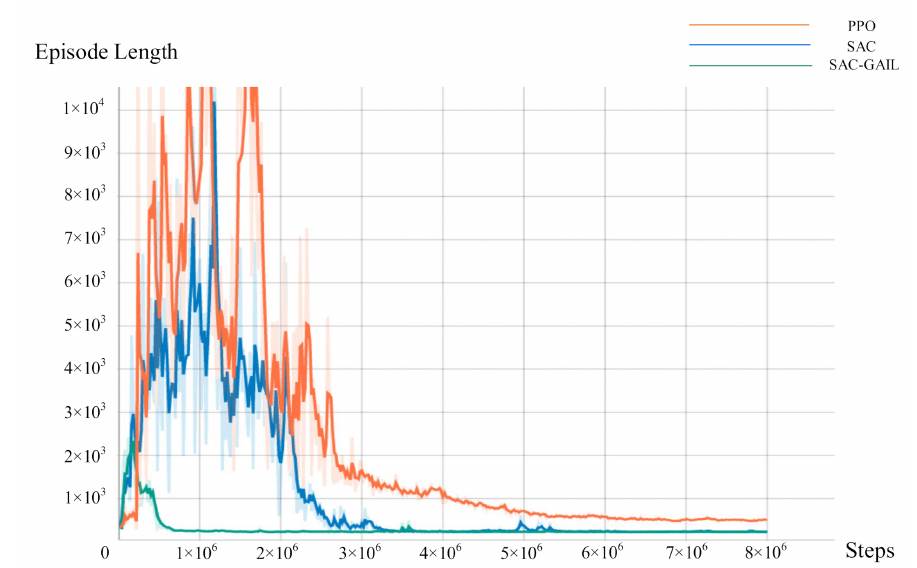
Figure 10. Curve of the episode length.